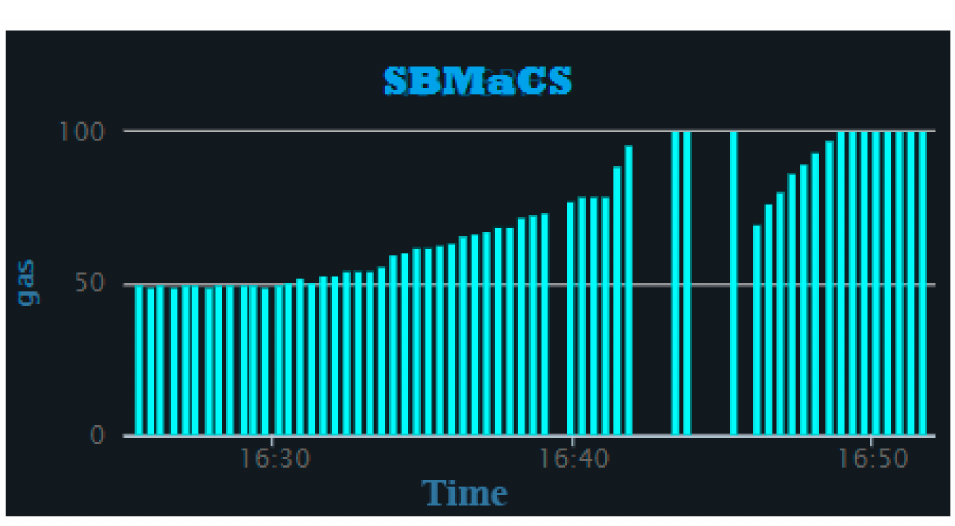
Figure 18. Gas vs.